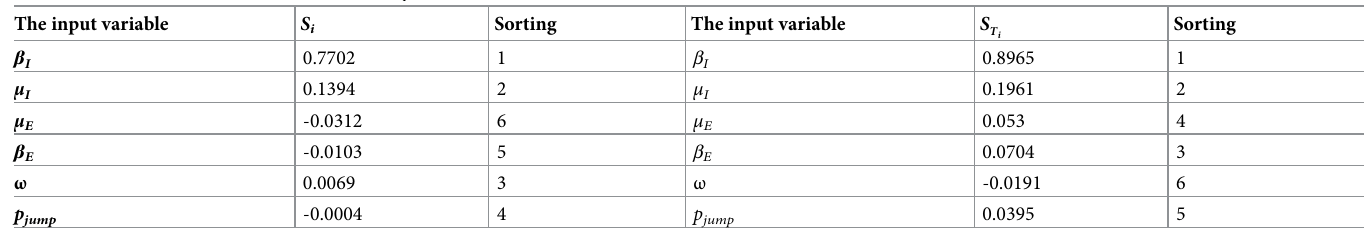
Table 2. Sensitivity index of each variable to ρ